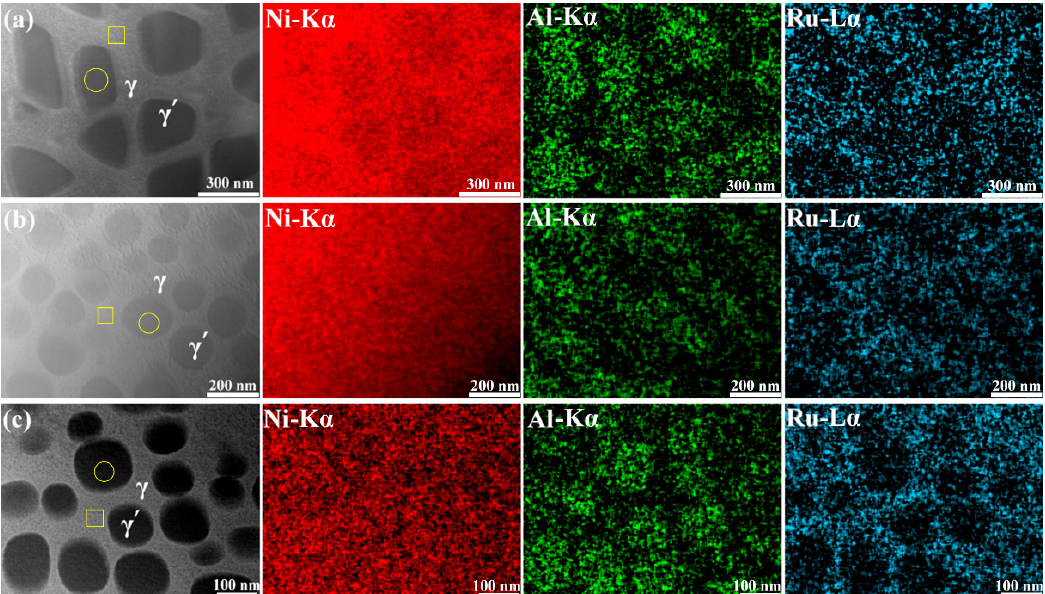
Figure 3. HAADF STEM images and EDS mappings of elements distribution for samples NiAl1Ru ( a ), NiAl3Ru ( b ), and NiAl6Ru ( c ) after aging for 4 h (yellow circles and boxes represent the EDS detecting location on γ′ and γ phases, respectively).